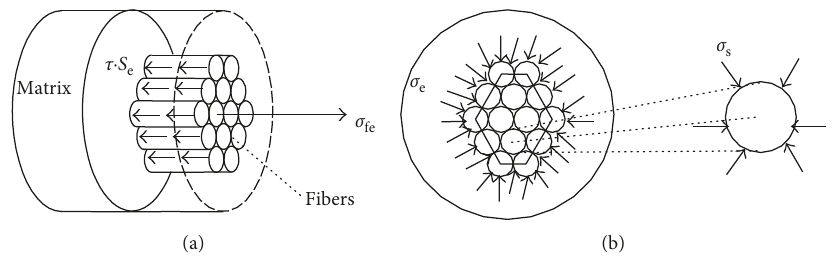
Figure 6: Micromechanics model of cluster-fiber-reinforced epoxy matrix composites.